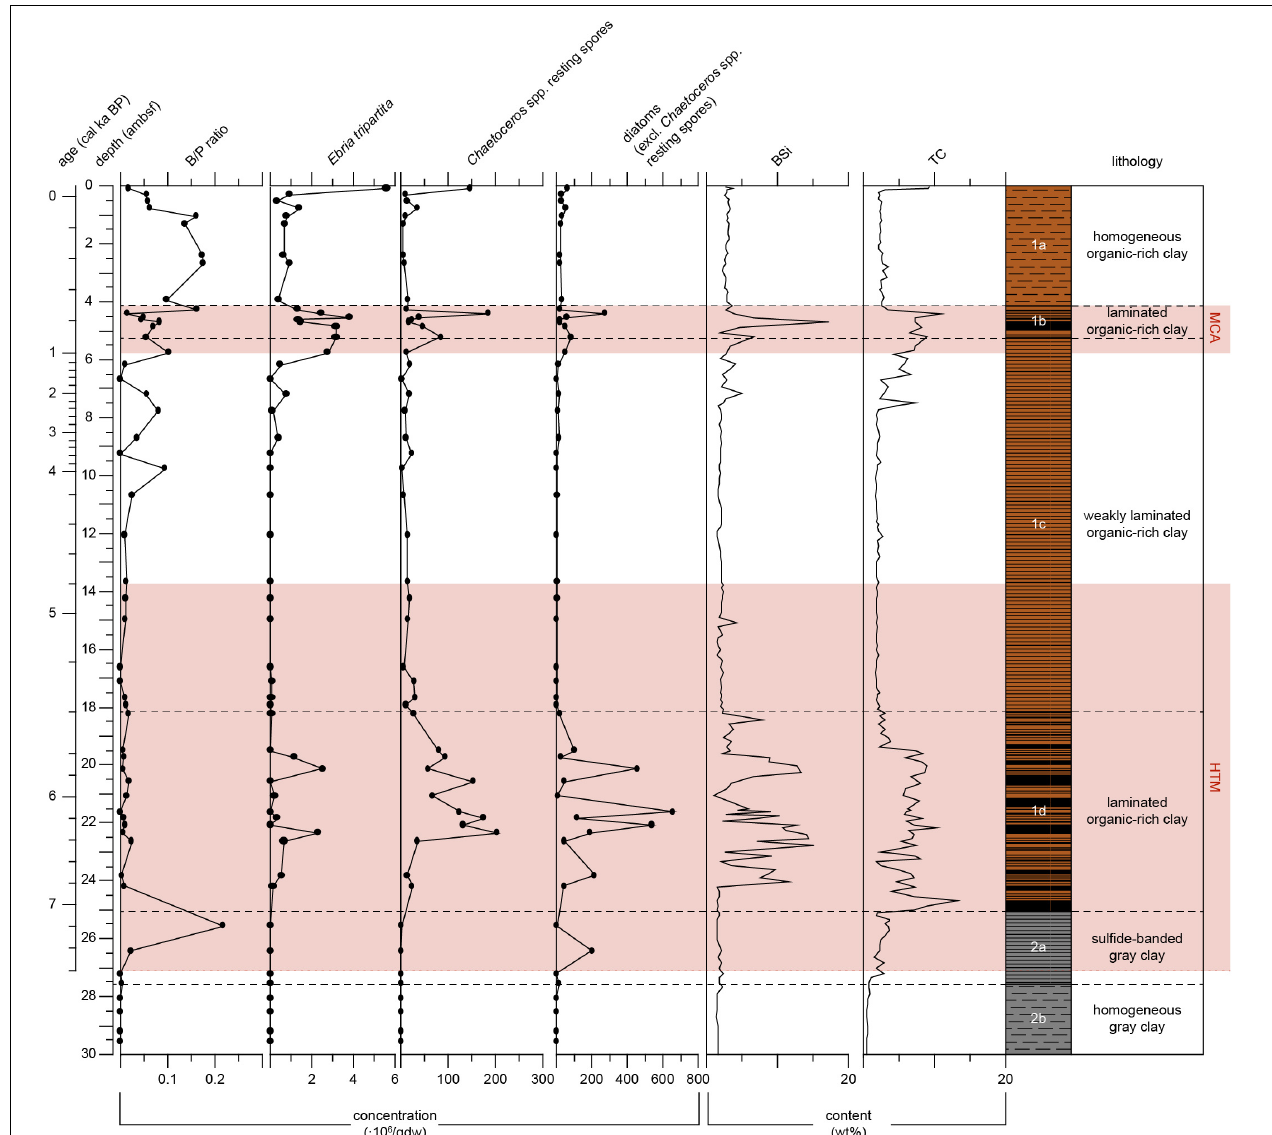
FIGURE 5 | Proxy records for primary productivity of Integrated Ocean Drilling Program Expedition 347 core M0063D plotted versus depth (adjusted meters below seafloor). The ratio of benthic to pelagic diatoms (B/P ratio) has no unit. Absolute abundance of Ebria tripartita , Chaetoceros spp. resting spores and vegetative diatom valves in millions of valves per gram dry weight (gdw). Biogenic silica (BSi) and total carbon (TC) content of the sediments (wt%). The warm climate anomalies Holocene Thermal Maximum (HTM, 8–4.8 cal ka BP, Seppä et al., 2009) and Medieval Climate Anomaly [MCA, 1.0 – 0.7 cal ka BP(MCA, 1.0 - 0.7 cal ka BP, Mann et al., 2009)] are represented by the light red areas. Lithology and sedimentological units are obtained from Andrén et al.